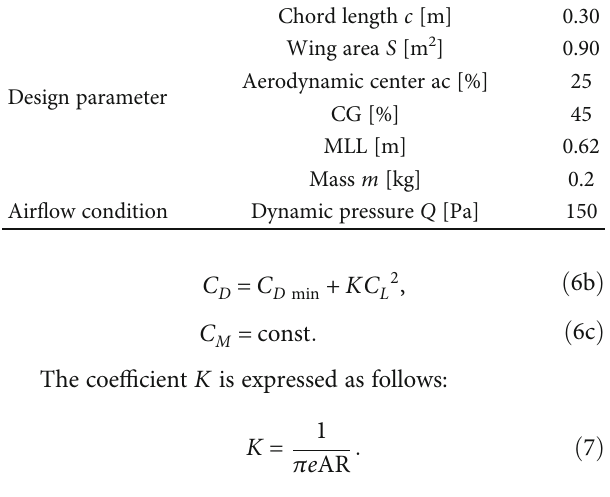
Table 2: Design parameters and mainstream